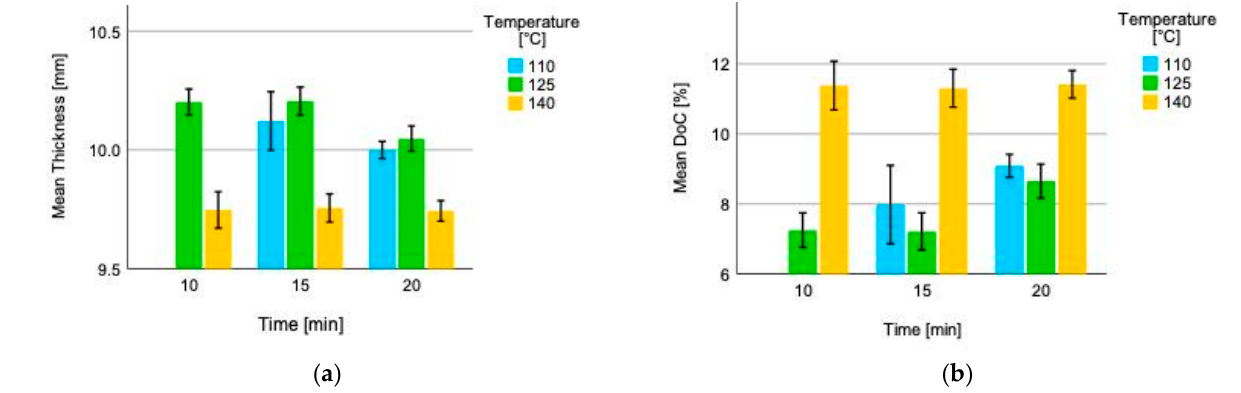
Figure 5. ( a ) Mean thickness and ( b ) mean degree of compression (DoC) of five layered Quebracho tannin furfural bonded plywood. The brackets within the figure indicate the interval ±1 standard deviation (SD).